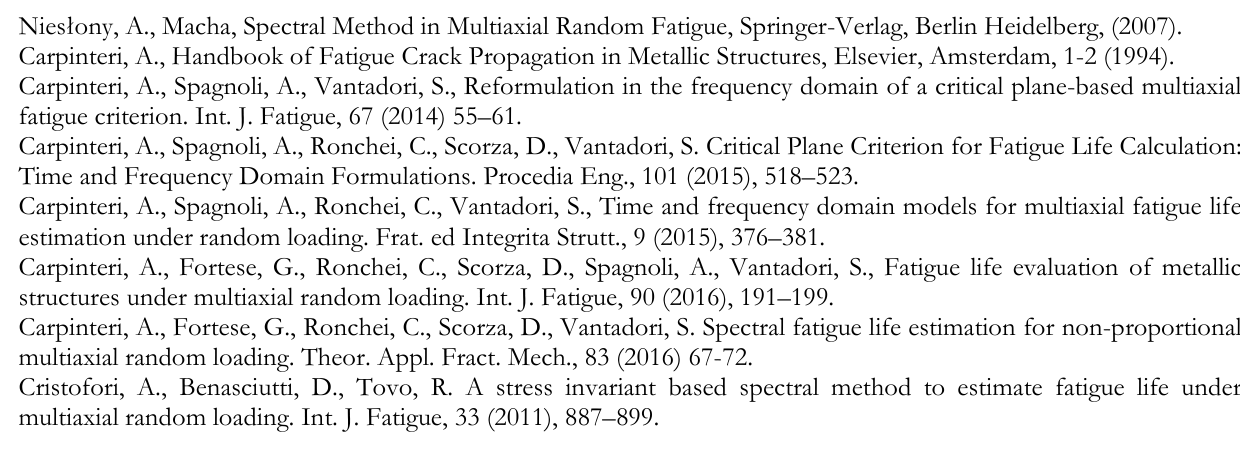
E D : partially overlapped ref